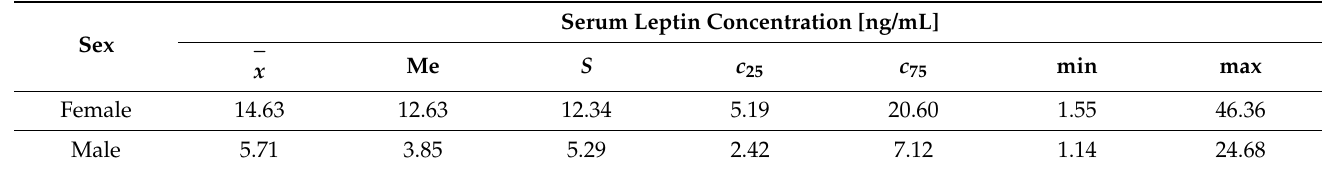
Table 2. The concentration of leptin in the blood serum among patients in the study group. Sex